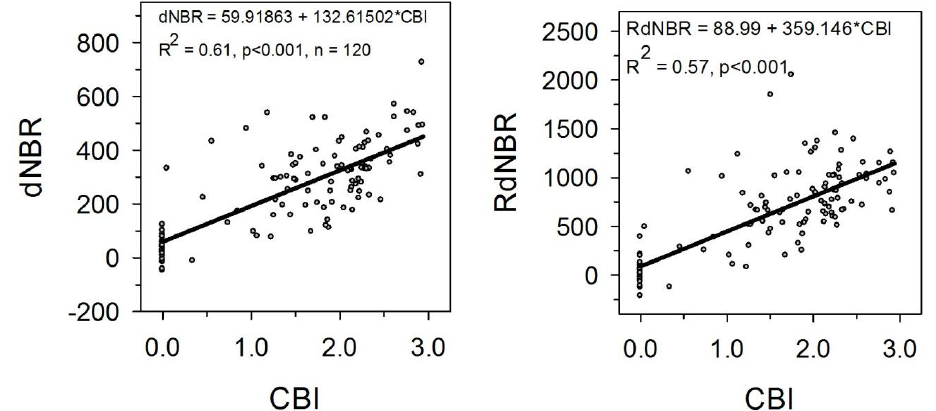
Figure 5. Scatterplots and regression models for initial assessment satellite imagery burn ratios predicting CBI from the full set of burned and unburned plots ( n = 120). The use of non-linear models did not improve the predictive ability of